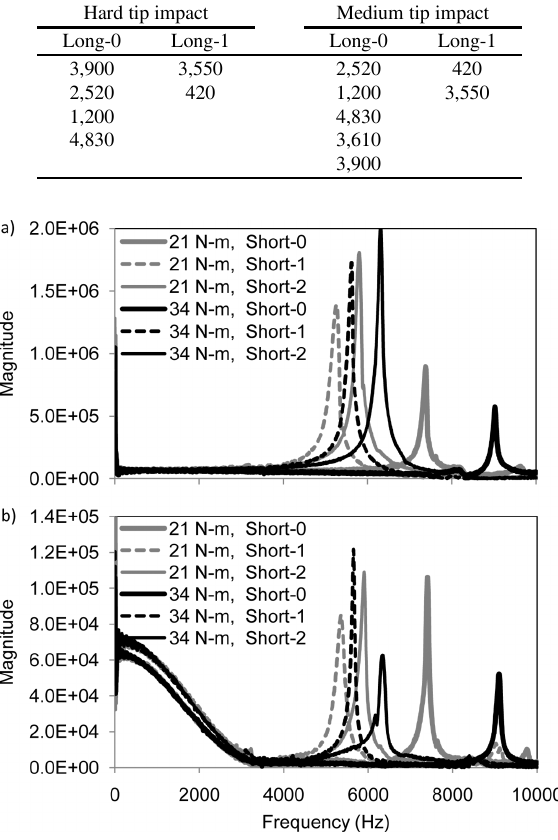
Fig. 7. Experimental results of FFT response of the short structure under impact loading using (a) hard and (b) medium tip impacts. FFT responses of the long structures while the short structures showed only one clear peak in each con fi guration. The ‘Long-0’ con fi guration had the highest peak at 3,900 Hz for hard and 2,520 Hz for medium tips, while ‘Long-1’ con fi guration had highest peaks at 3,550 Hz for hard and 420 Hz for medium tips. For both impact cases, ‘Long-1’ showed the highest peak at lower frequency than that of